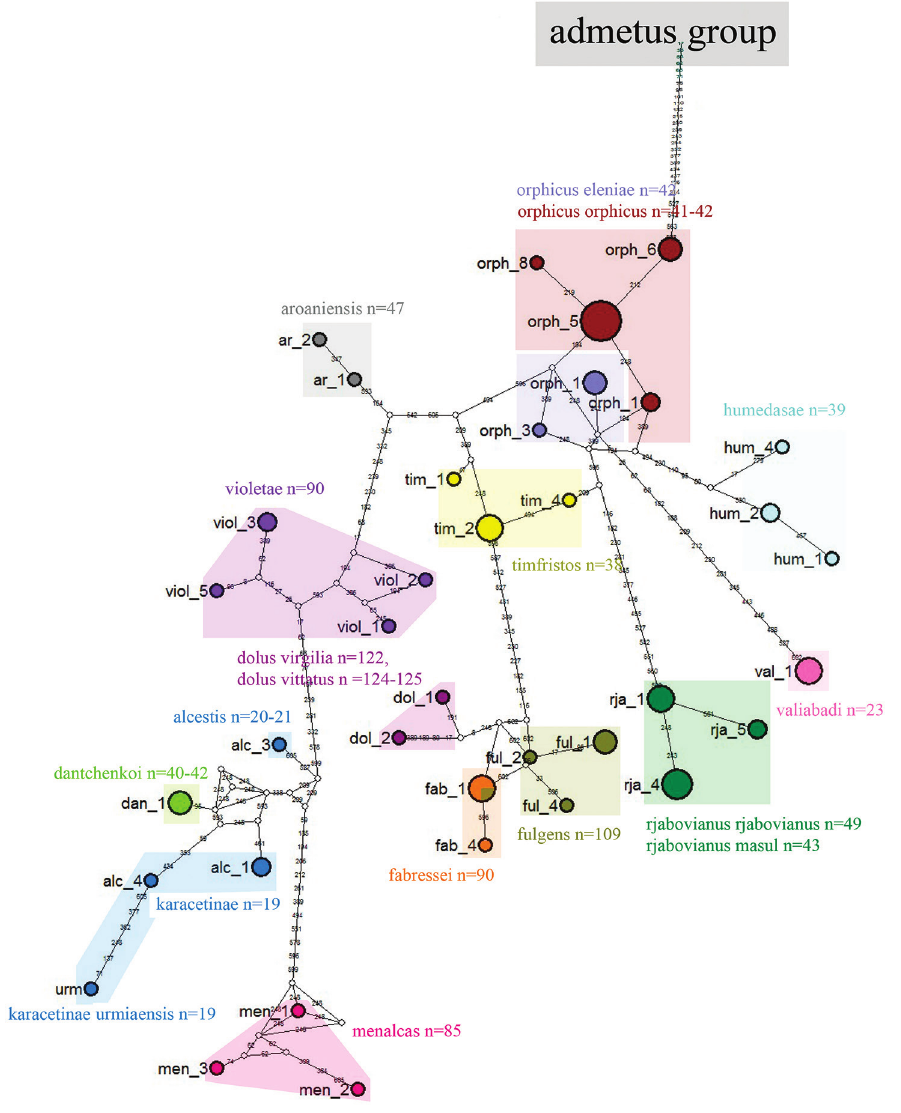
Figure 11. Haplotype network of P. dolus species group. Colored circles represent different taxa. Each line segment represents a mutation step, and white small circles represent “missing” haplotypes.